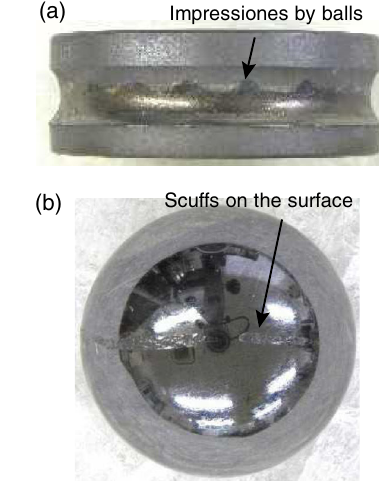
FIG. 8. Beam loss monitor signal distribution when a single- shot beam with the power equivalent to 1.2 MW is fully lost. The signal is integrated for one cycle from the beam injection to the extraction, 20 ms. The position of the failed TMP system is also shown. The beam loss signal distribution in the normal 1 MW equivalent beam acceleration case is also shown for reference.